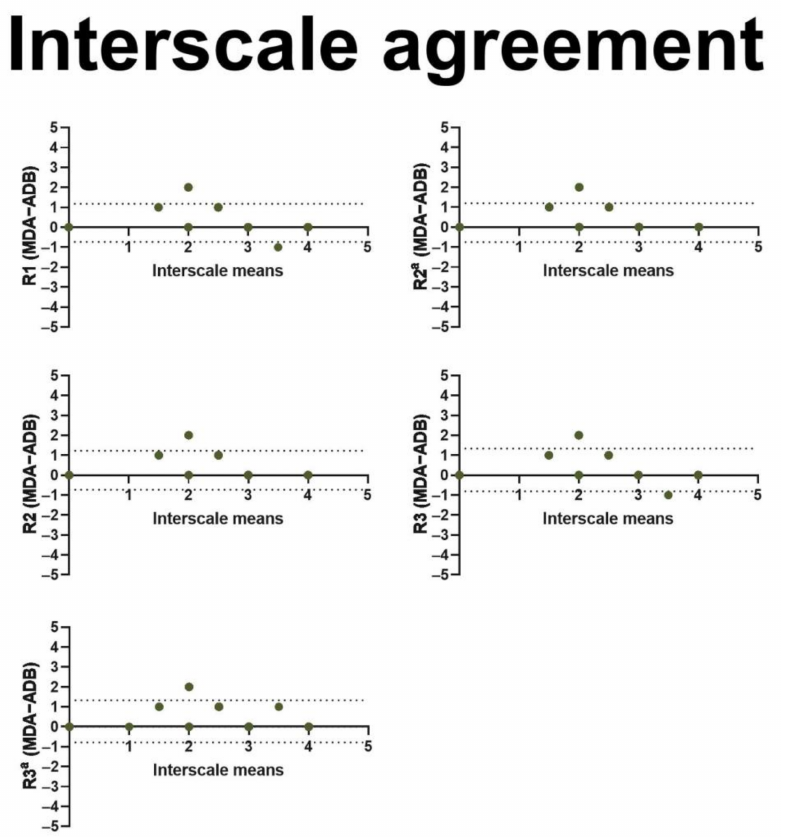
Figure 4. This figure shows Bland–Altman plots for interscale agreements between the MD Anderson and the Arm Dermal Backflow stages. The x-axis represents the mean interscale stage (range: 0–5). The y-axis shows the difference in interscale staging (range: − 5–5). The horizontal dotted lines denote the 95% confidence intervals for the limits of agreement. R1 = rater 1, R2 = rater 2, R3 = rater 3. a = second